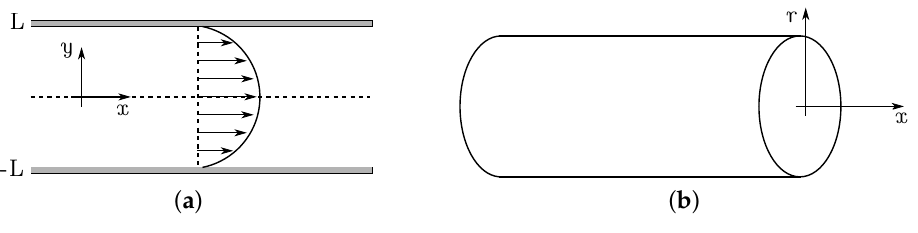
Figure 1. Poiseuille planar channel ( a ), and Poiseuille pipe ( b ) flows. With the adopted formulation, the x -momentum equation does not change with the non-Newtonian constitutive model and can be integrated to